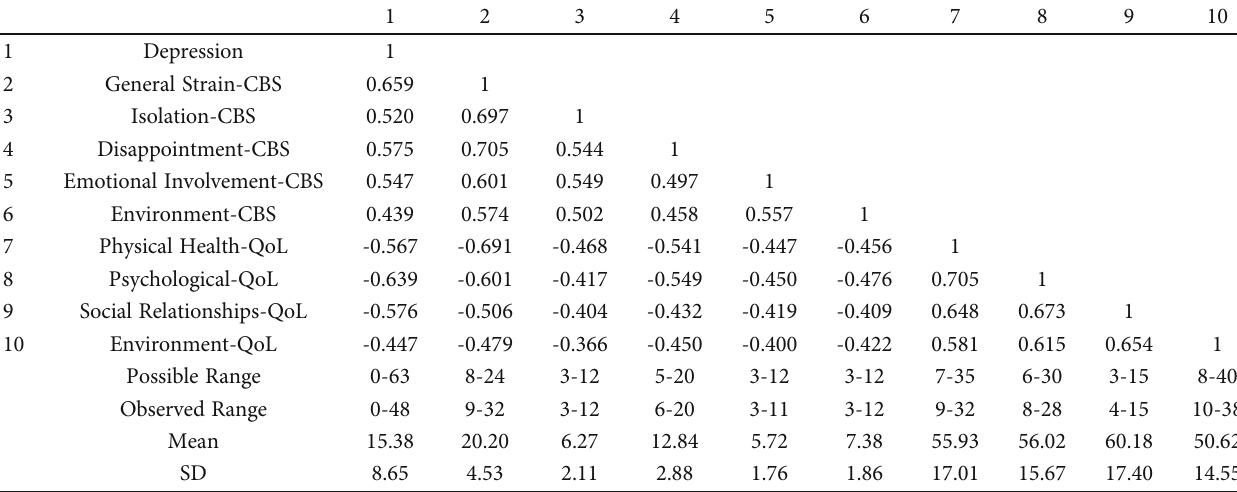
Table 1: Means, standard deviations, and correlations among study variables ( n = 135